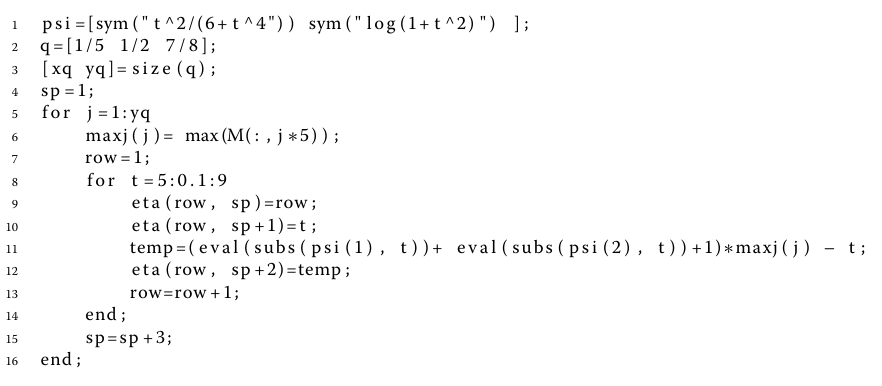
Algorithm 6 MATLAB lines for finding suitable values of η in Eq. (27) for q variable in Example 4.2